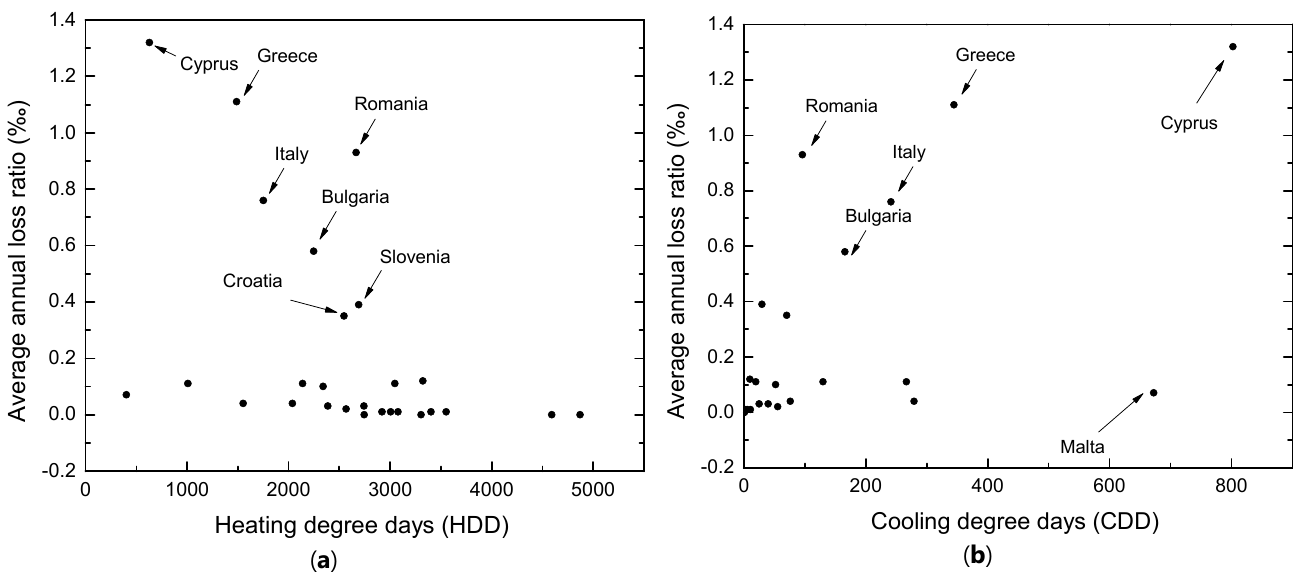
Figure 7. Definition of priority regions: ( a ) AALR vs. HDD; and ( b ) AALR vs. CDD. The same observation can be made for the relationship between CDD and AALR, shown in Figure 7b. It can be observed that Cyprus is a country with high AALR and CDD simultaneously. After that, Greece, Italy, Bulgaria and Romania have higher AALR and CDD. The remaining countries, typically north and central European Countries, have low CDD and AALR. Malta is the second country with a higher CDD but has a low AALR. The definition of climate plus seismic scenarios for each region of the EU is herein performed based on the two inputs: AALR and a climate indicator (CI). Nine different EU zones are herein proposed based on the combination of AALR and CI. The zones were defined based on the EU’s AALR and CI range values. Three different levels of AALR are proposed: low (AALR < 0.30‰); medium (0.30‰ ≤ AALR < 0.60‰); and high (AALR ≥ 0.60‰). The CI was computed for each country according to Equation (1). Then, three different levels are proposed: low (CI < 1500); medium (1500 ≤ CI < 3000); and high (CI ≥ 3000). Thus, the seismic–climate matrix for the definition of the EU zone is presented in Figure 8. It should be stressed that CI greatly depends on the HDD and more minorly on